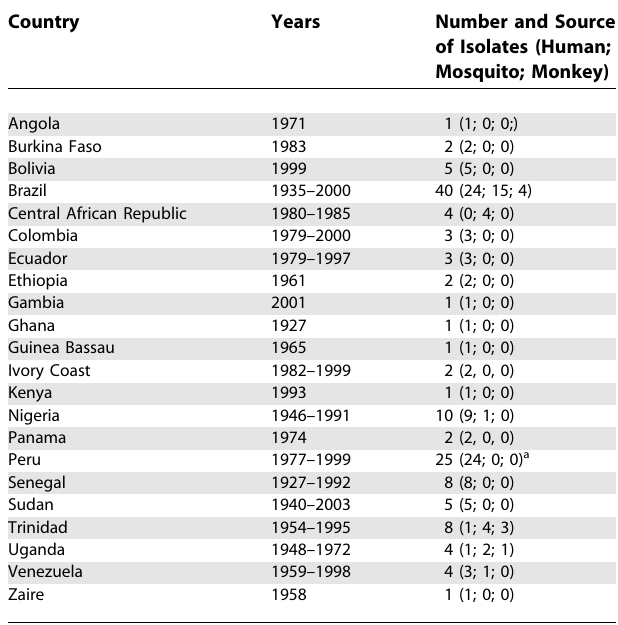
Table 1. Summary of Yellow Fever Virus prM/E Gene Sequences Used in This